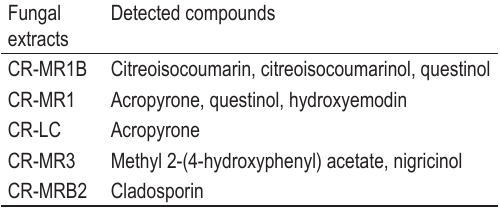
FIGURE 2. UV‑spectra of detected compounds, (A) Citreoisocoumarin, (B) Citreoisocoumarinol, (C) Questinol, (D) Acropyrone, (E) Hydroxyemodin, (F) Methyl 2‑(4‑hydroxyphenyl) acetate, (G) Nigricinol, (H) TABLE 3. Bioactive compounds detected in endophytic fungal extracts by HPLC‑DAD analysis